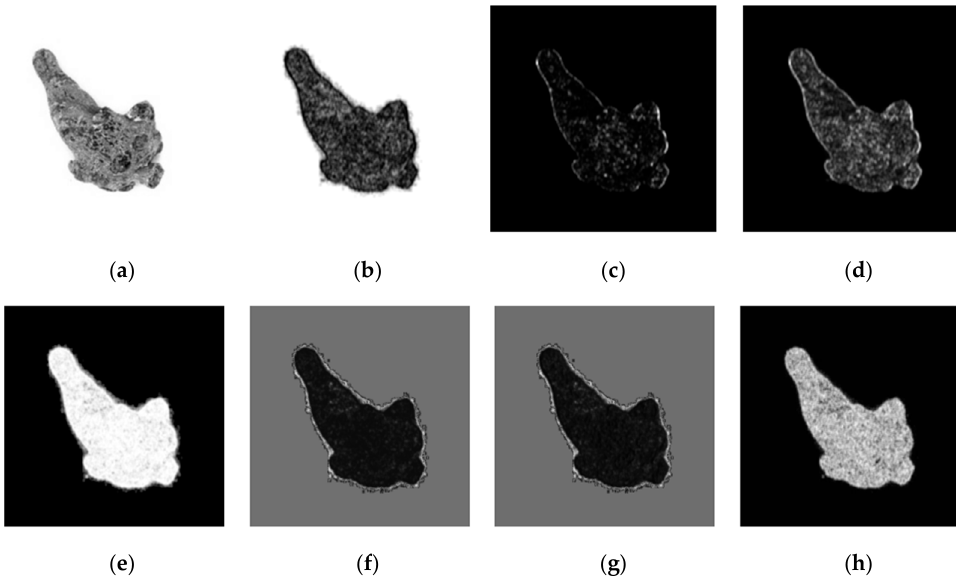
Figure 6. A visualization of the seven texture features. ( a ) Original image, ( b ) homogeneity, ( c ) con- trast, ( d ) dissimilarity, ( e ) entropy, ( f ) energy, ( g ) correlation, ( h ) auto-correlation.